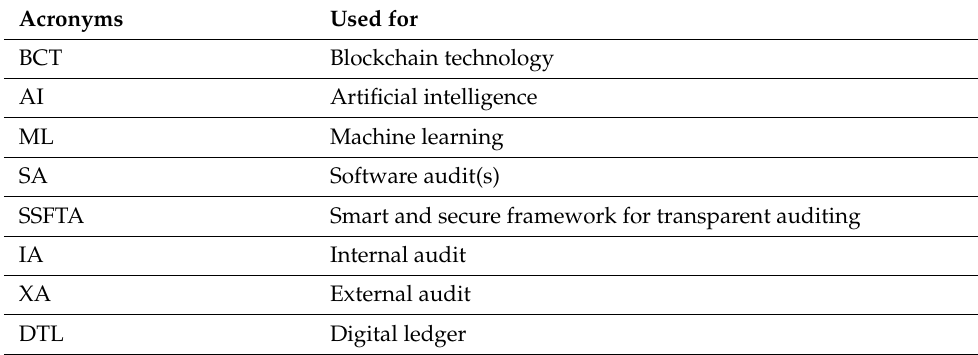
Figure 1. Paper organization. Table 1. List of acronyms and their details .